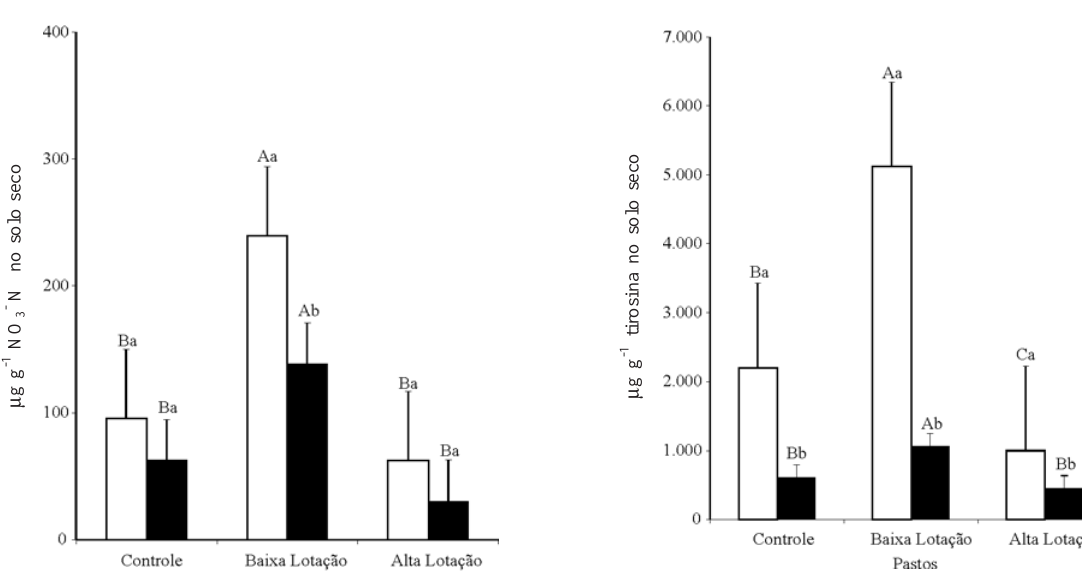
Figura 5. Atividade proteolítica encontrada nas camadas de 0–10 ( ) e 10–20 cm ( ) do solo pastejado por ovinos. Médias seguidas de mesma letra, minúscula (profundidade) e maiúscula (pastos), dentro de cada variável, não diferem entre si pelo teste de Tukey a 5 %. As barras representam o erro-padrão (n = 15).